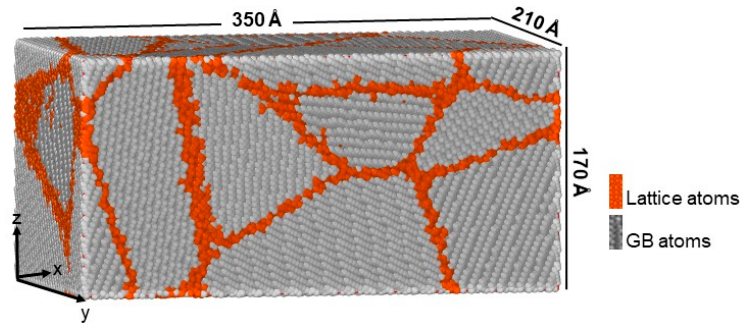
Figure 1. Simulation cell of nc ferrite with average grain size of 8 nm.